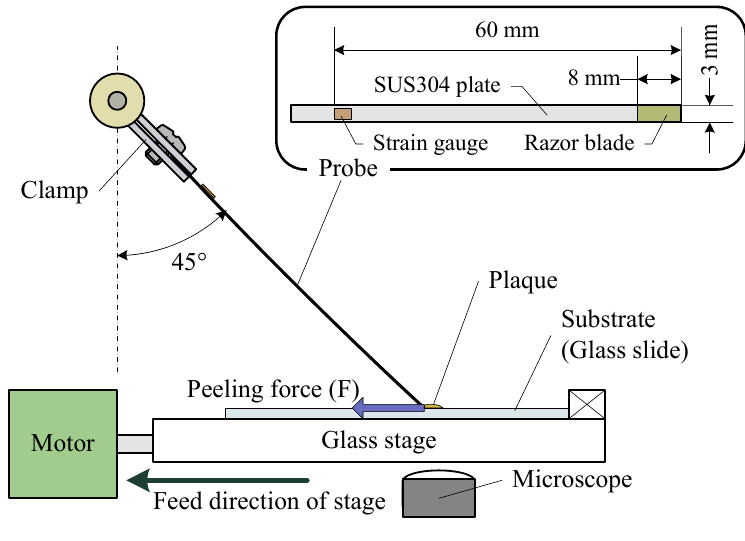
Fig. 7 Schematic views of the peel test